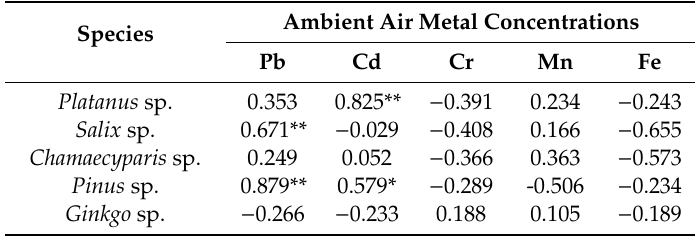
Table 4. Correlation coe ffi cients of metal concentration in five tree species and ambient air (1996–2012). Ambient Air Metal Concentrations Species Pb Cd Cr Mn Fe Platanus sp. 0.353 0.825** − 0.391 0.234 − 0.243 Salix sp. 0.671** − 0.029 − 0.408 0.166 Chamaecyparis